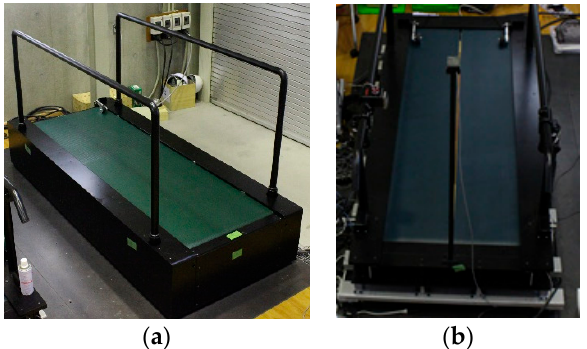
Figure 1. Treadmill installed with force plates. ( a ) A single-belt treadmill installed with a force plate. ( b ) The dual-belt type treadmill installed with two force plates.